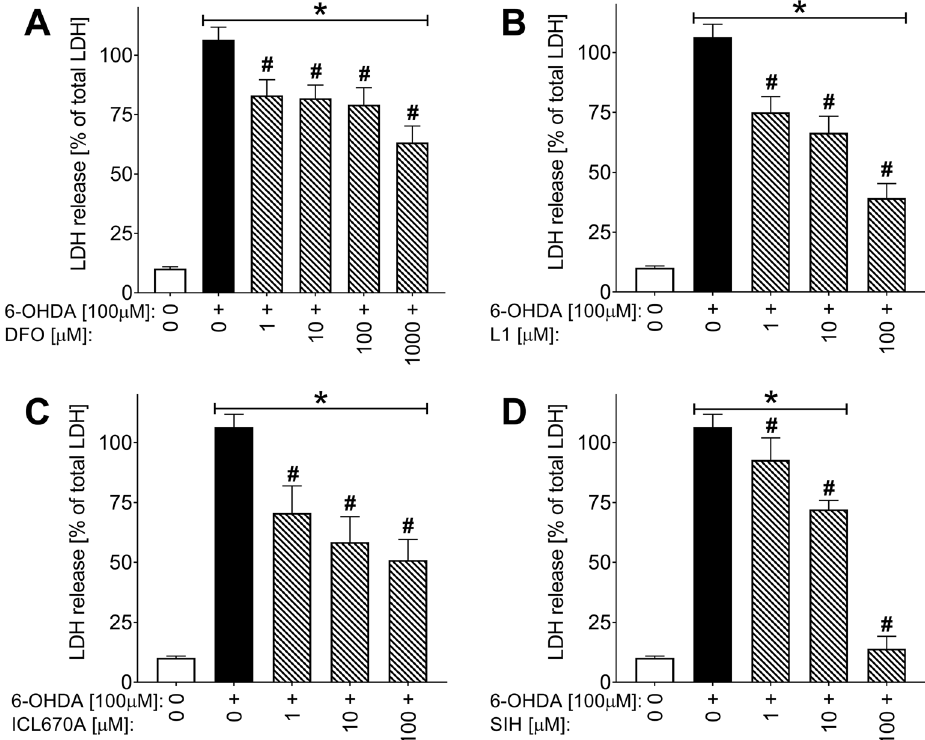
Figure 3. Comparison of protective effects of Fe chelators DFO, ICL670A, L1 and SIH against 6-hydroxydopamine (6-OHDA)-induced toxicity in differentiated PC12 cells. Cellular toxicities were determined using LDH activity assay and expressed as a percentage of the LDH released from completely lysed control cells. Studied Fe chelators were added to freshly-prepared 6-OHDA in the medium before the start of 24 h cellular experiments (protocol PI ). Data are presented as means ± SD ; n ≥ 4; Statistical significance (ANOVA, p ≤ 0.05): * vs. control group, # vs. 6-OHDA